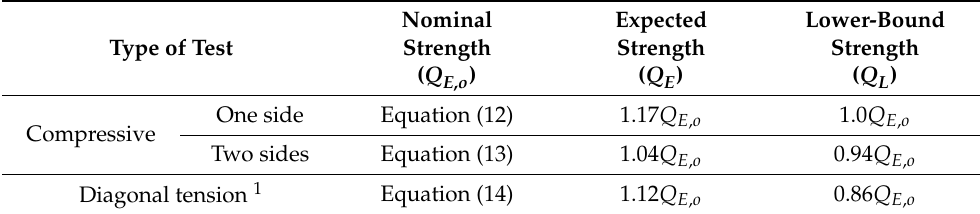
Table 9. Nominal strength and modification factors for concrete brick